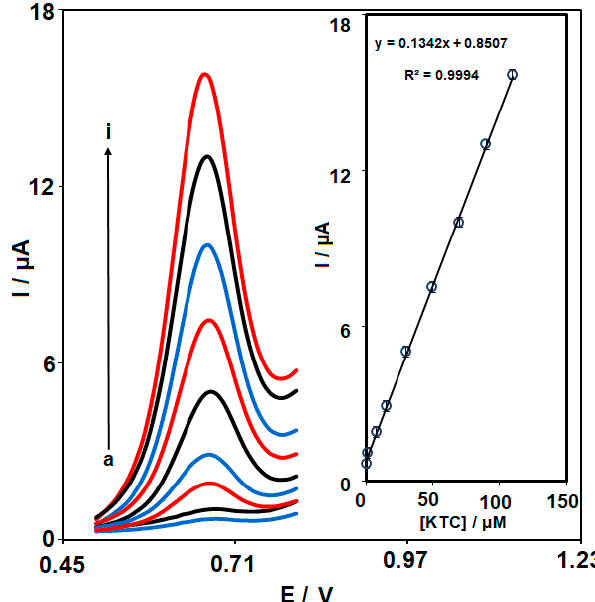
Figure 9. DPVs captured for the oxidation of variable KTC contents on the Ce-BTC MOF/IL/CPE under variable contents (a–i: 0.1, 1.0, 7.5, 15.0, 30.0, 50.0, 70.0, 90.0, and 110.0 μ M). Inset: calibration curve of voltammetric response (I pa ) against KTC level.